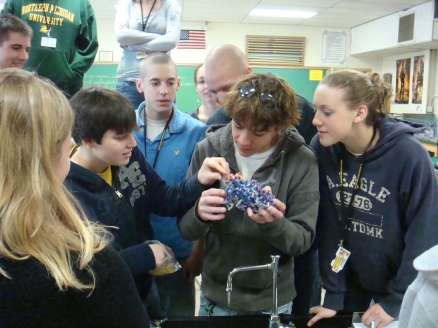
Creating the “Aha” MomentMembers of the Brown Deer High School SMART Team examine the alanine-to-arginine mutation on their physical model of the maspin protein.